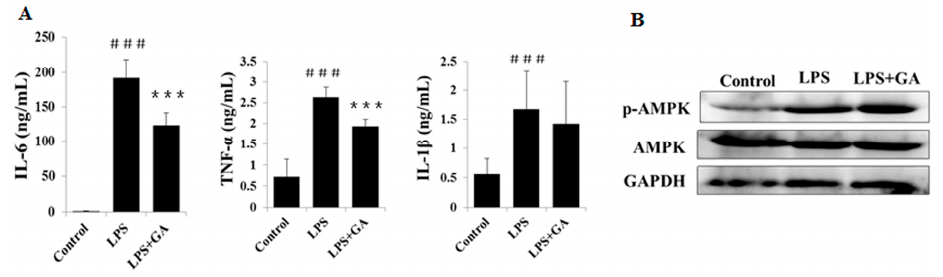
Figure 7. GA attenuates inflammatory response in LPS-treated BALB/c mice. ( A ) Effects of GA on production of TNF- α , IL-6, and IL-1 β in LPS-induced BALB/c mice. BALB/c mice were randomly divided into three groups. The control group was administered the same amount of solvent i.p. ( n = 5). The LPS-induced group was administered LPS (250 μ g/kg) ( n = 6). The treatment group was administered LPS (250 μ g/kg) and GA (20 mg/kg) at the same time ( n = 5). Two hours after the injection, blood was harvested, and serum was separated to measure IL-6 ( left ), TNF- α ( middle ) and IL-1 β ( right ) levels by ELISA. ### p < 0.001 versus control group; *** p < 0.05 versus LPS-treated group. ( B ) The effects of GA on the AMPK pathways in LPS-treated BALB/c mice. BALB/c mice were treated with the same method as in ( A ). Blood samples were treated with red blood cell lysis buffer to harvest immune cells for analysis of AMPK phosphorylation by Western blotting.